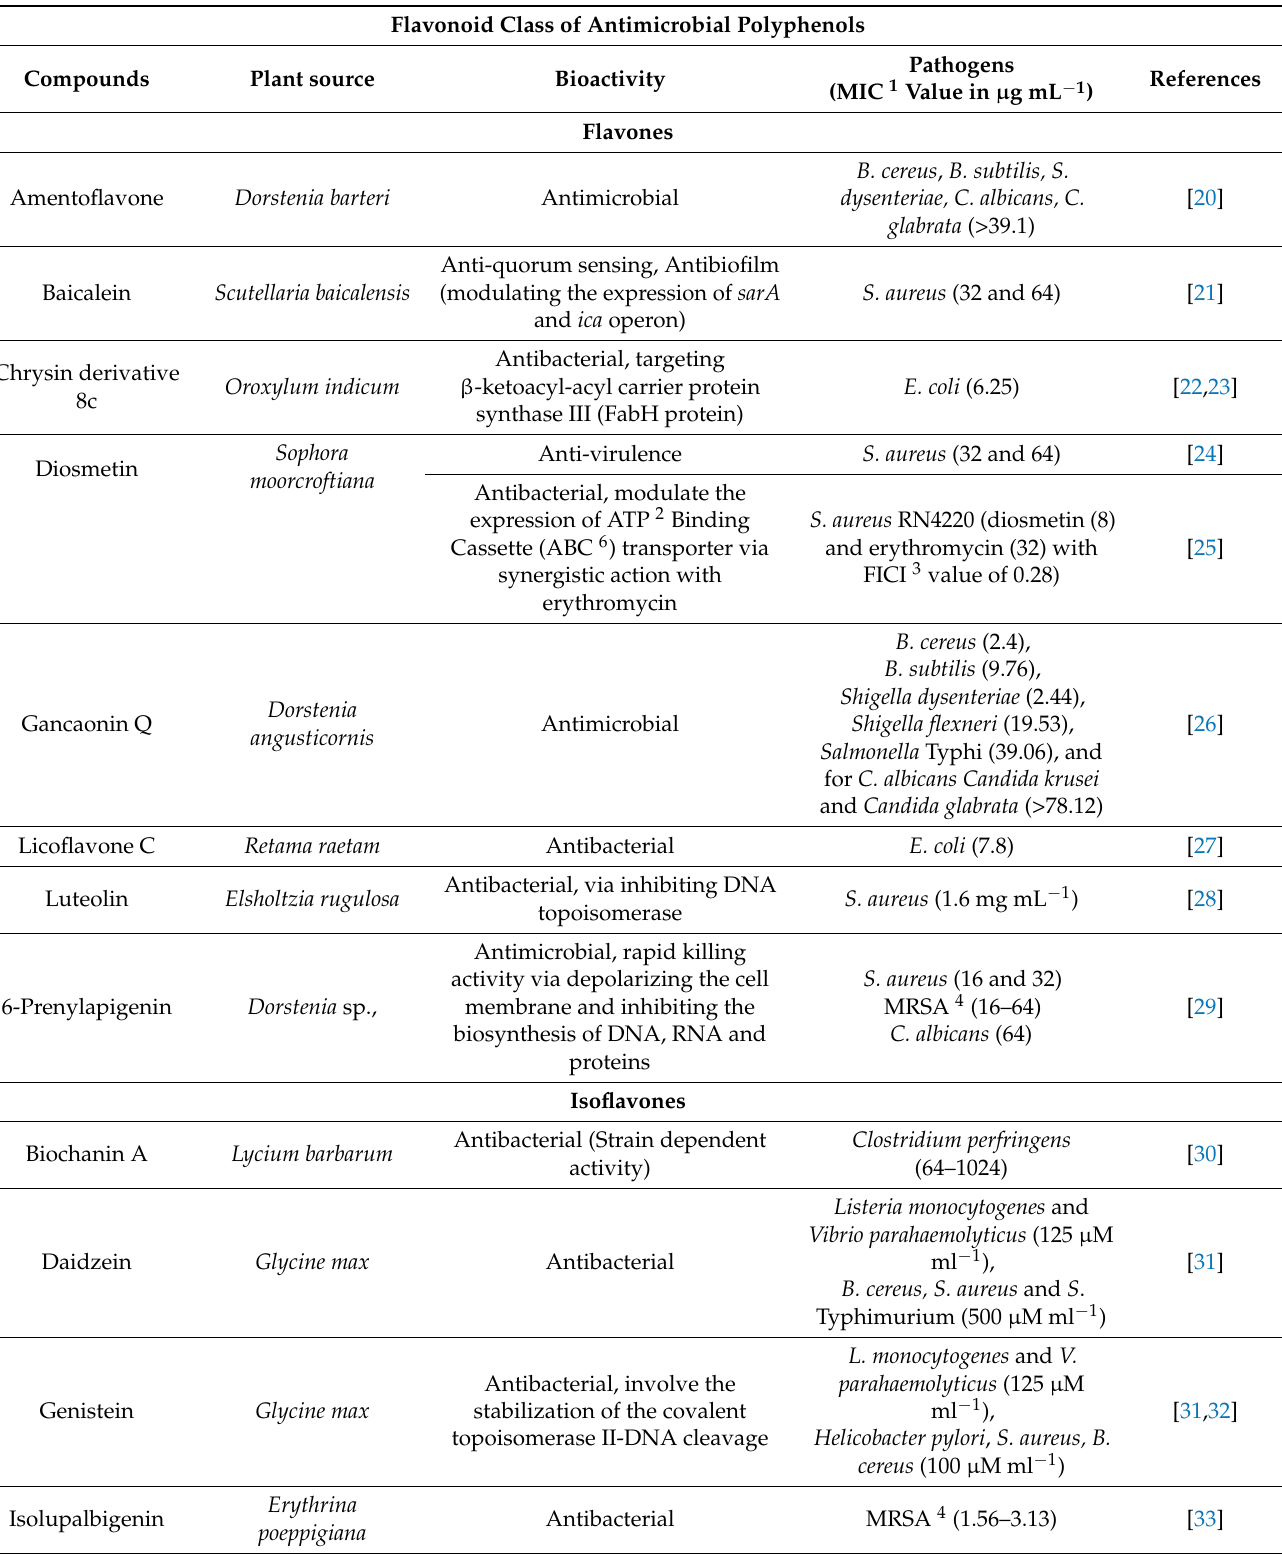
Table 1. A representation of antimicrobial polyphenols from flavonoid and non-flavonoid classes with food preservative